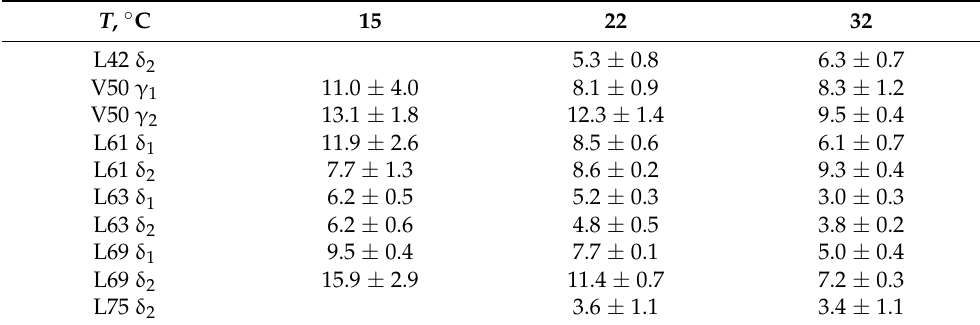
Table 2. List of experimental η HH/CH rates obtained for HP36 perdeuterated/LV protonated protein in the presence of 28% w / w deuterated glycerol The units are s − 1 . At 15 ◦ C the L75- δ 2 and L42- δ 2 sites are not included due to spectral